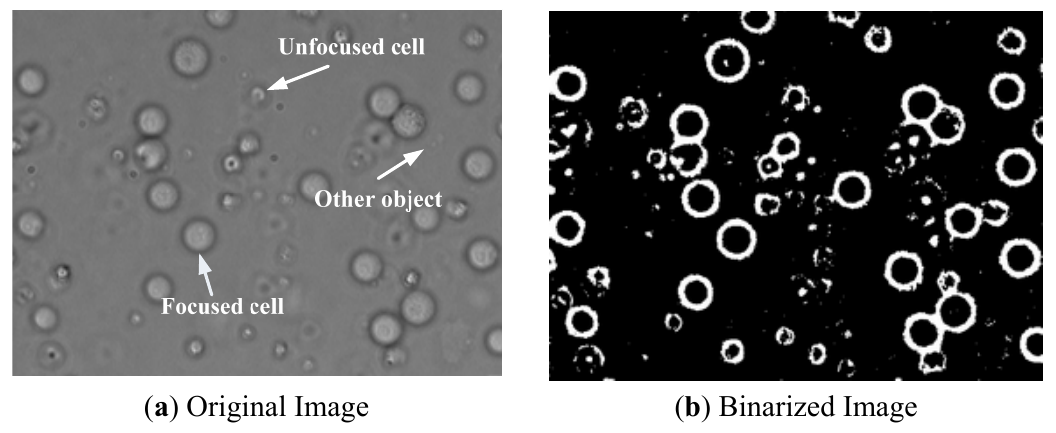
Figure 3. The compared picture after image binarization.